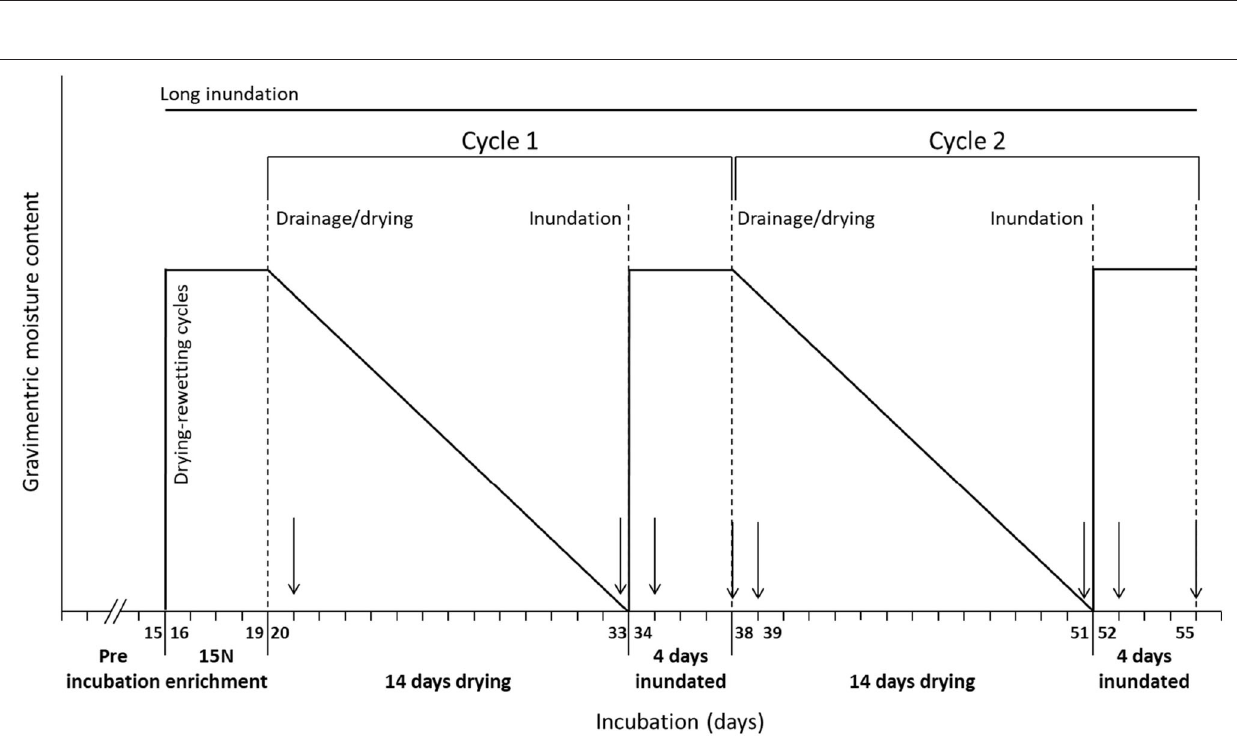
FIGURE 2 | Schematic diagram of the experimental design and drying-rewetting cycles. The arrows show sampling dates (sampling frequency equal for all cores). Nine cores were kept inundated until the end of the experiment (long inundation cores) and nine cores were subject to two consecutive drying-rewetting cycles (drying-short inundation